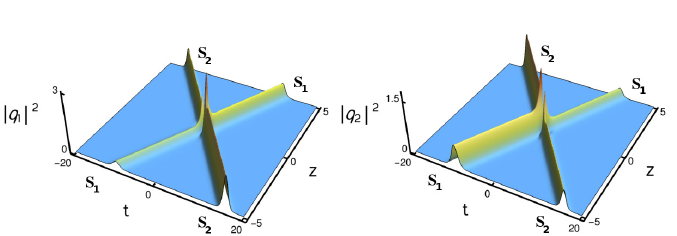
Figure 7. Shape changing collision of the degenerate two-solitons: k 1 = l 1 = 1 + i , k 2 = l 2 = ( 1 ) = 0.5 + 0.5 i , α ( 1 ) 1.51 − 1.51 i , α 1